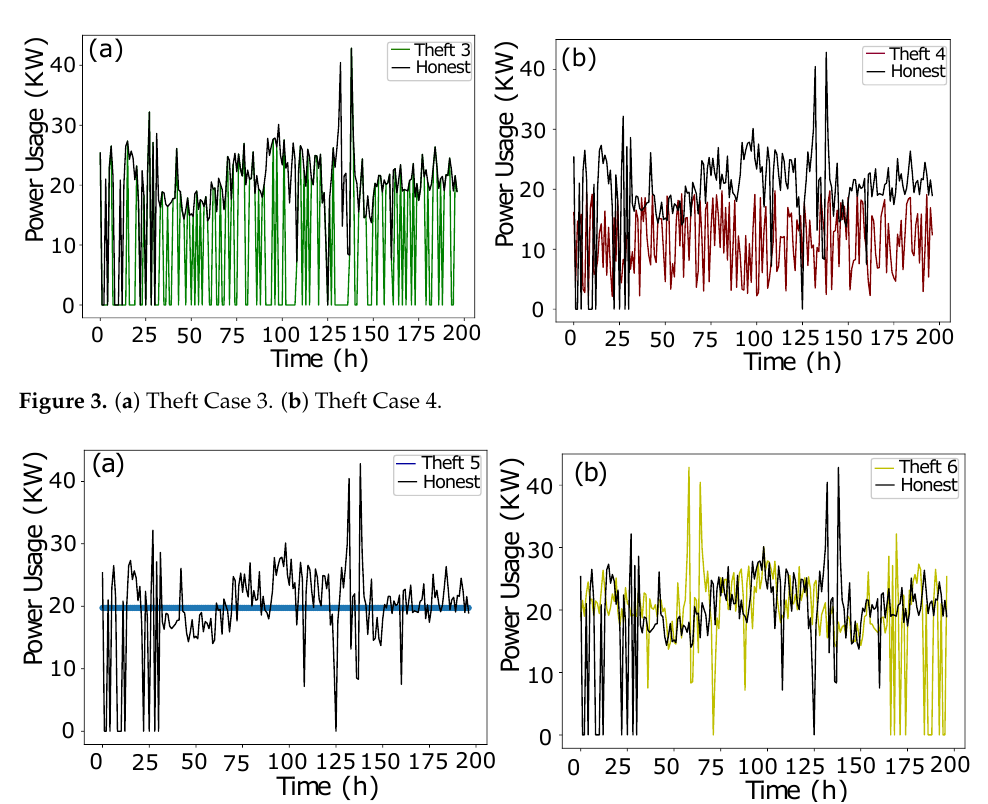
Figure 4. ( a ) Theft Case 5. ( b ) Theft Case